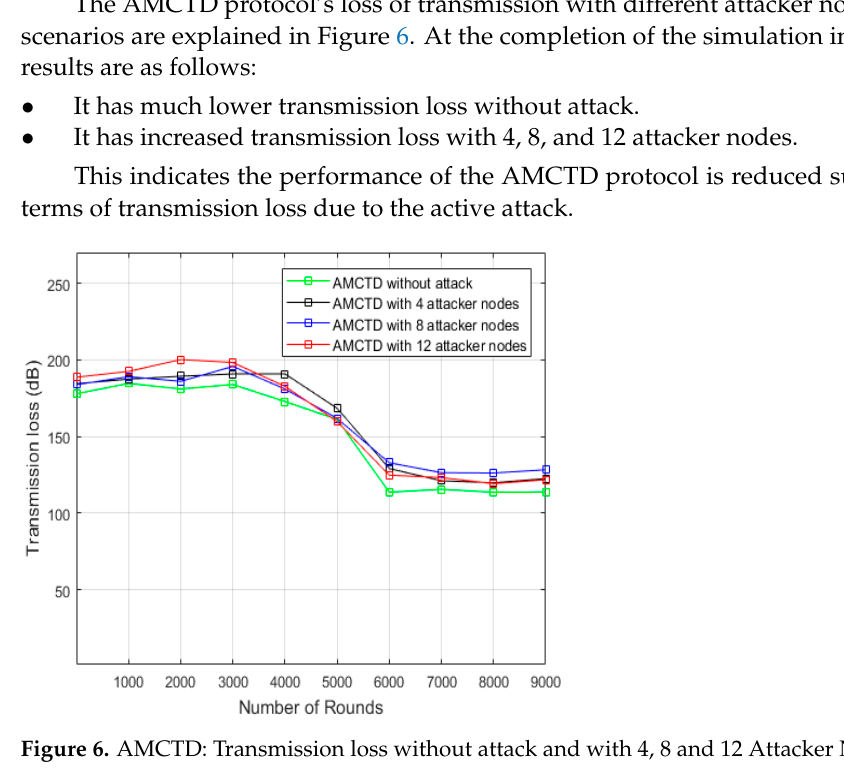
Figure 8. AMCTD: Throughput Analysis without attack and with 4, 8 and 12 Attacker Nodes.